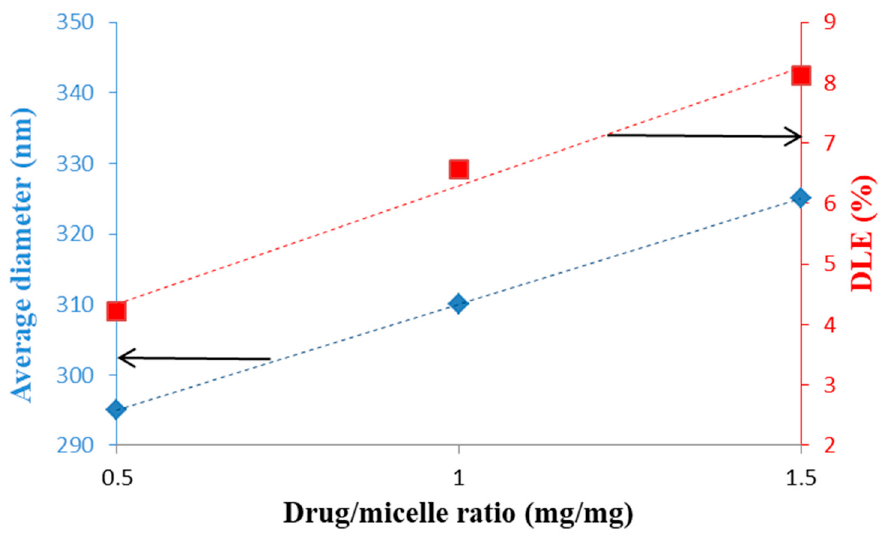
Figure 13. Evolution of the average micellar diameters and DLE as a function of the Dox/micelle ratio (mg/mg) (redrawn from [86]).